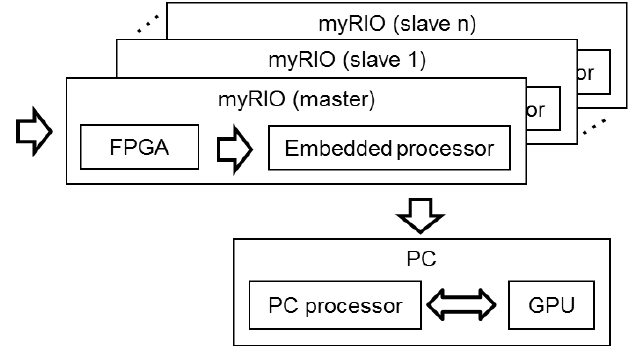
Figure 2. Global hardware setup.